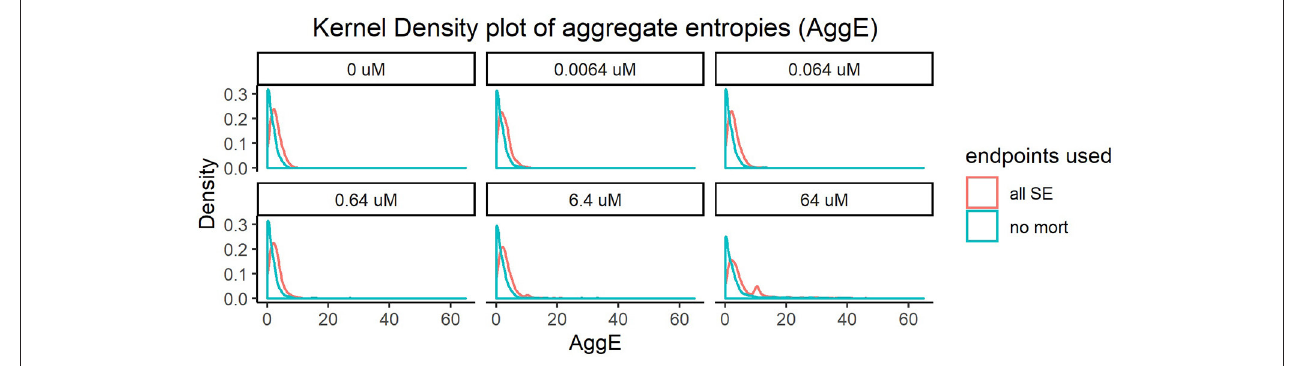
FIGURE 1 | Kernel density plot of Aggregate entropies (AggE) of 1060 ToxCast chemicals before and after removing mortality information. The density histogram plots AggE on the horizontal axis. The red line represents the distribution of AggE for chemicals obtained by summarizing information from all Super Endpoints (all SE) and the blue line represents AggE of chemicals after excluding data from mortality endpoint.